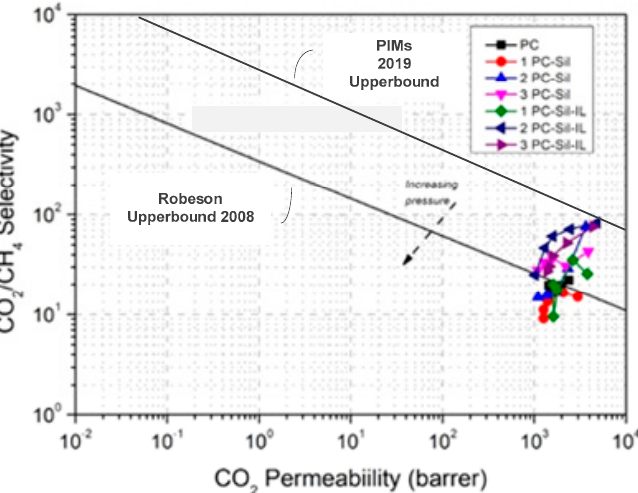
Figure 8. Comparison of separation performance for fabricated PC, PC-Sil, PC-Sil-IL MMMs with 2008 Robeson upper bound and PIMs 2019 redefined upper bound [37,38].